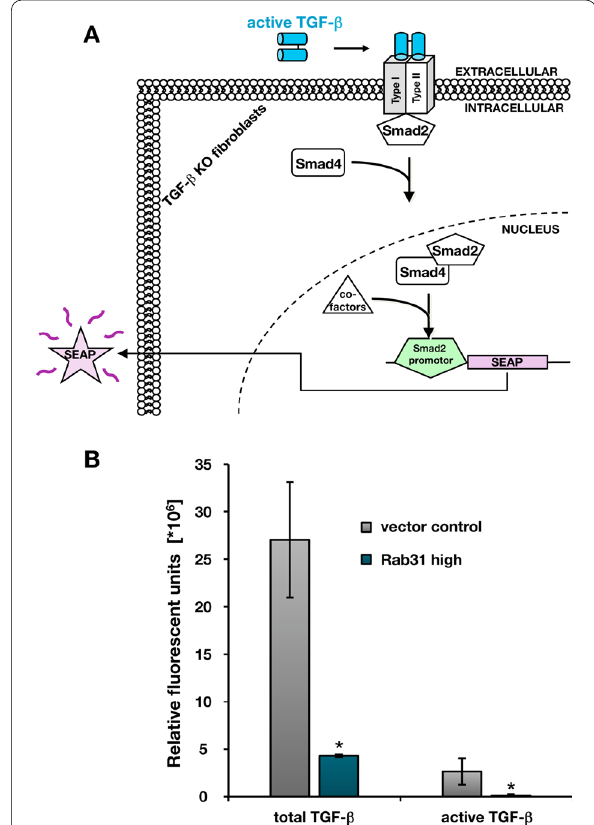
overexpressing and vector control cells. A Outline of the human TGF-ß activity assay. Concentrated supernatants (1:16) from CAMA-1 Rab31 overexpressing and vector control cells, were added to murine TGFB1 / fibroblasts transfected with a TGF-ß reporter plasmid. − − This plasmid encodes secreted alkaline phosphatase (SEAP) under the control of SMAD-binding elements (SBE). SEAP activity is then determined by a chemiluminescent reaction. B CAMA-1 cell culture supernatants were heat-activated to measure total TGF-ß levels (left panel), or left untreated to measure active TGF-ß levels (right panel). Statistically significant differences (p < 0.05) are indicated by an